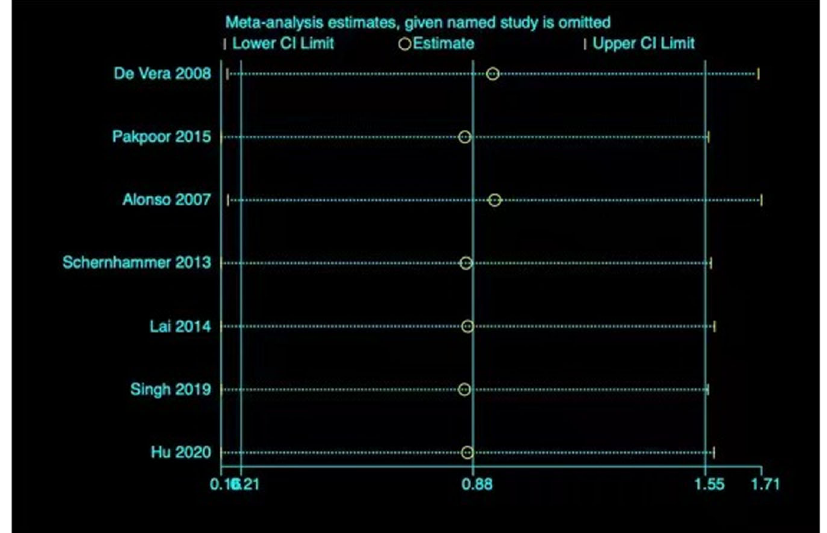
Fig. 7 Sensitivity analysis omitting each study in turn from the analyses on the correlation between gout and the risk of PD. The vertical lines show the summary estimate (0.88) and its 95% CI (0.21 – 1.55) from the meta-analysis of all the